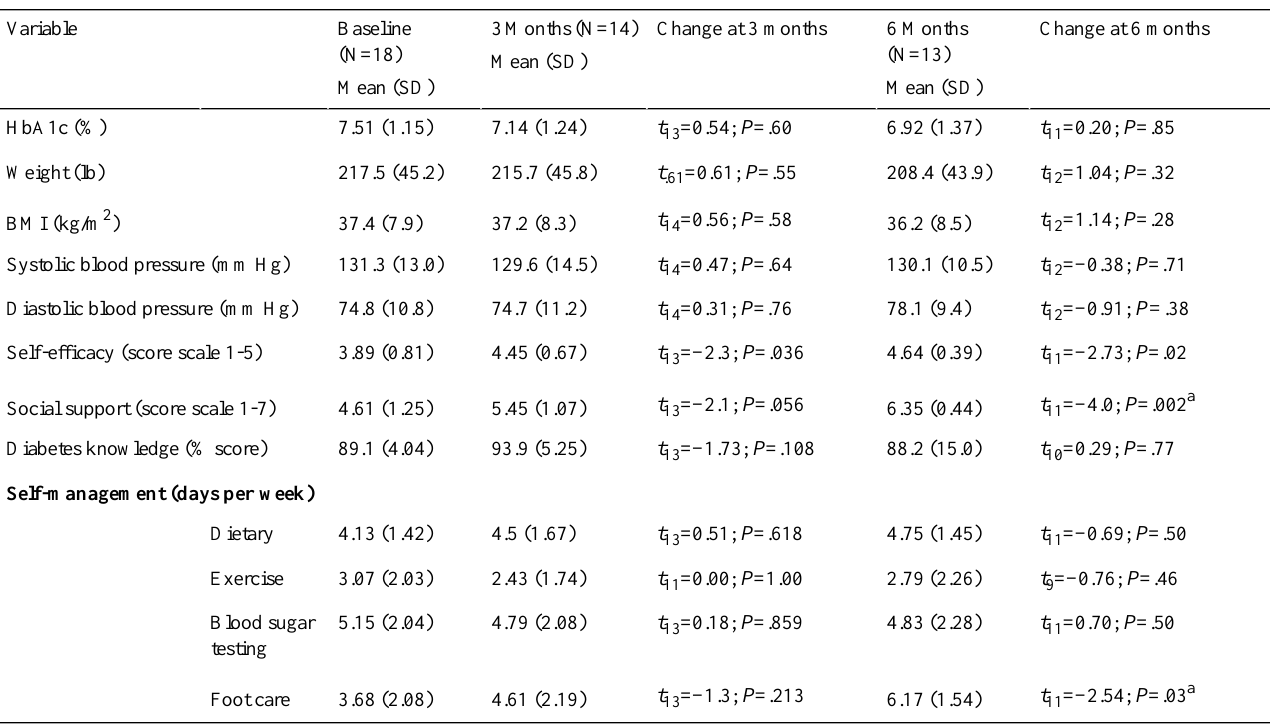
Table 4. Physiological and psychosocial